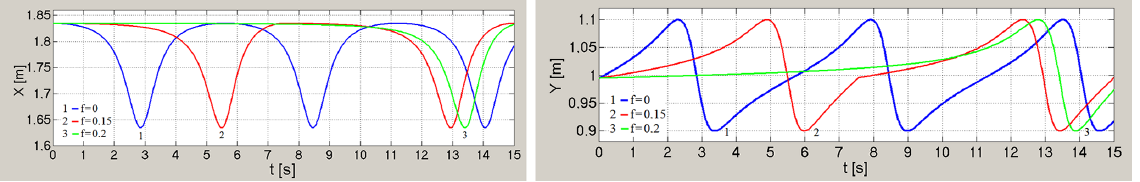
Figure 19. Graphs of coordinates X ( t ) and Y ( t ) of point C at different values of the coefficient of sliding friction f and for coefficient of rotational friction k = 0 and for load mass M =